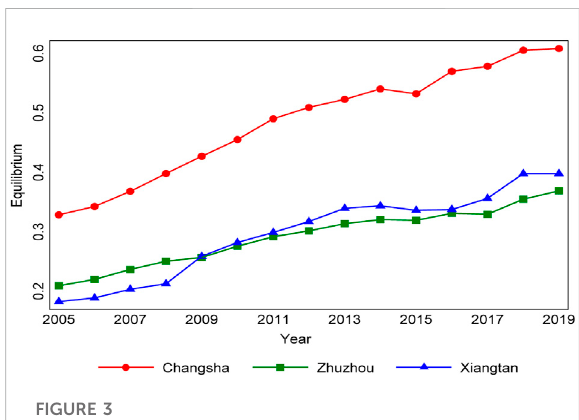
FIGURE 3 Time evolution trend of population spatial